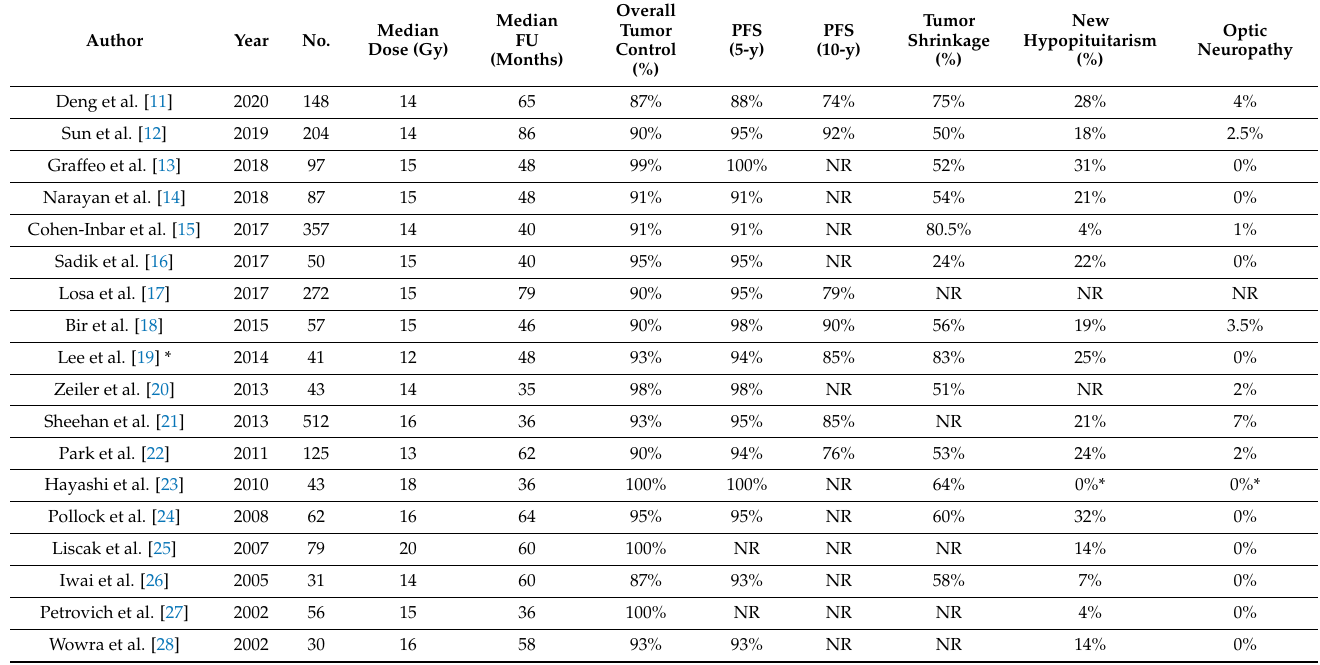
Table 1. Non-functioning pituitary adenoma Gamma Knife treatment outcomes and